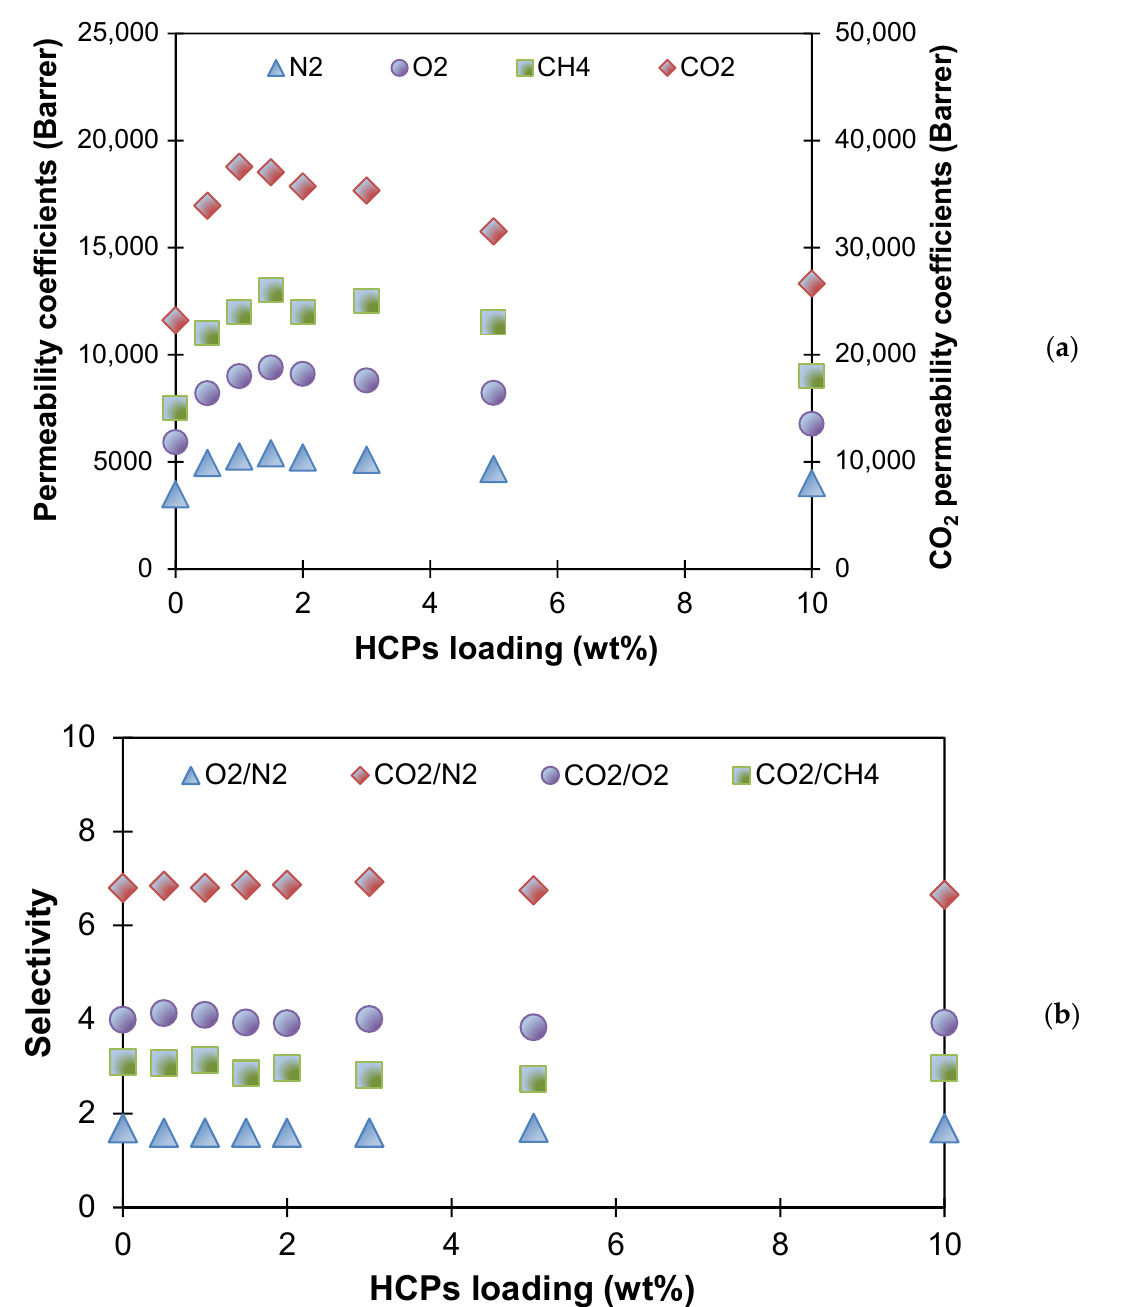
Figure 3. Dependencies of ( a ) permeability coefficients for light gases (N 2 , O 2 , CO 2 , CH 4 ) and ( b ) O 2 /N 2 , CO 2 /N 2 , CO 2 /O 2 , and CO 2 /CH 4 ideal selectivities on HCPS loading.